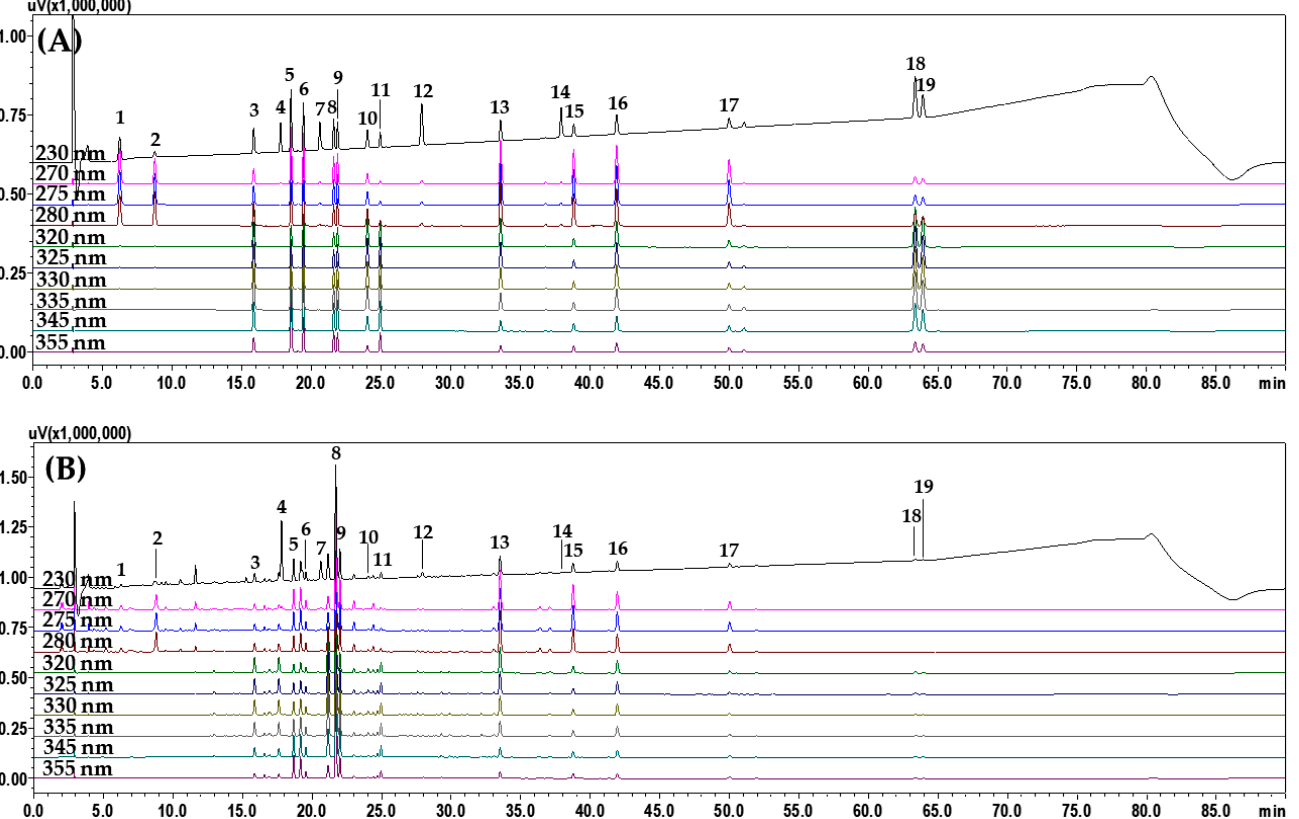
Figure 1. HPLC chromatograms of the standard solution ( A ) and OCE–1 sample ( B ). Gallic acid ( 1 ), 5-(hydroxymethyl)furfural ( 2 ), chlorogenic acid ( 3 ), geniposide ( 4 ), coptisine chloride ( 5 ), jatrorrhizine chloride ( 6 ), paeoniflorin ( 7 ), berberine chloride ( 8 ), palmatine chloride ( 9 ), ferulic acid ( 10 ), nodakenin ( 11 ), benzoic acid ( 12 ), baicalin ( 13 ), benzoylpaeoniflorin ( 14 ), wogonoside ( 15 ), baicalein ( 16 ), wogonin ( 17 ), decursin ( 18 ), and decursinol angelate ( 19 ). The concentration of each marker in the mixed standard solution is as follows: 10.00 µ g/mL (compounds 2 , 8 – 10 , and 17 ), 20.00 µ g/mL (com- pounds 3 , 6 , 11 , 12 , 15 , and 16 ), 30.00 µ g/mL (compounds 1 , 4 , 5 , and 13 ), 40.00 µ g/mL (compounds 14 , 18 , and 19 ), and 50.00 µ g/mL (compound 7